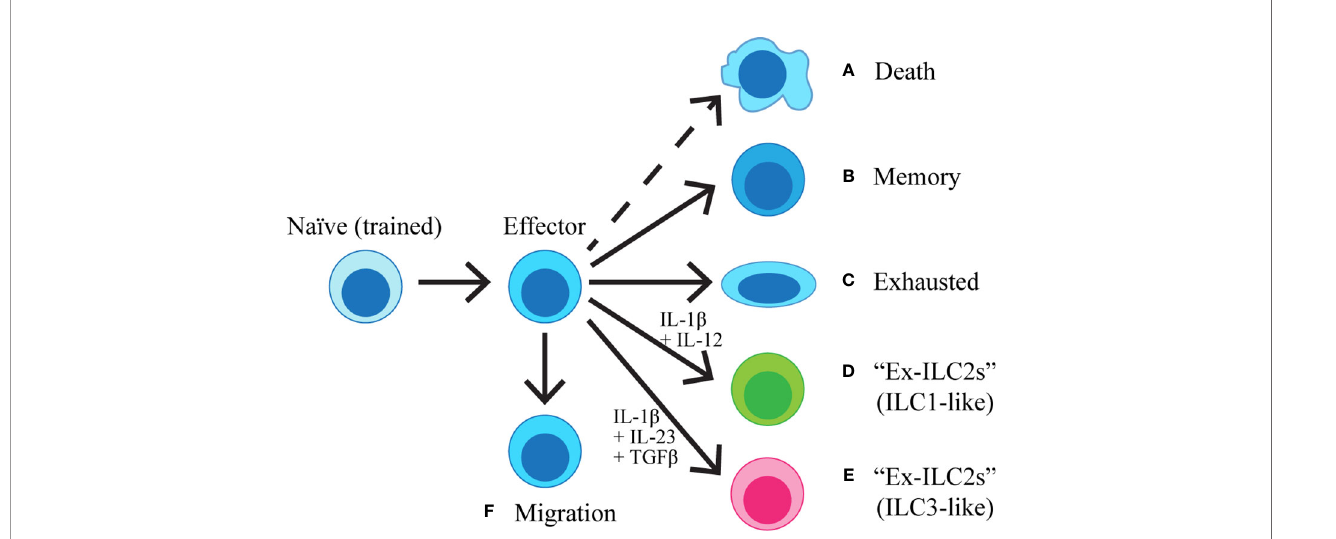
FIGURE 1 | Naïve ILC2s are exposed to IL-33 during the neonatal period and become “ trained ” . Once activated, ILC2s become effector cells, producing cytokines and initiating the in fl ammatory cascade. The majority of the effector cells are predicted to die (A) , while a proportion of ILC2s acquires immunological memory (B) . Some ILC2s may become exhausted (C) , whereas others can also transdifferentiate into IFN g -producing ILC1-like cells (D) or IL-17-producing ILC3-like cells (E) upon stimulation with IL-1 b + IL-12 or IL-1 b + IL-23 + TGF b , respectively. A subset of ILC2s migrates out of the lung and enter circulation (F) .